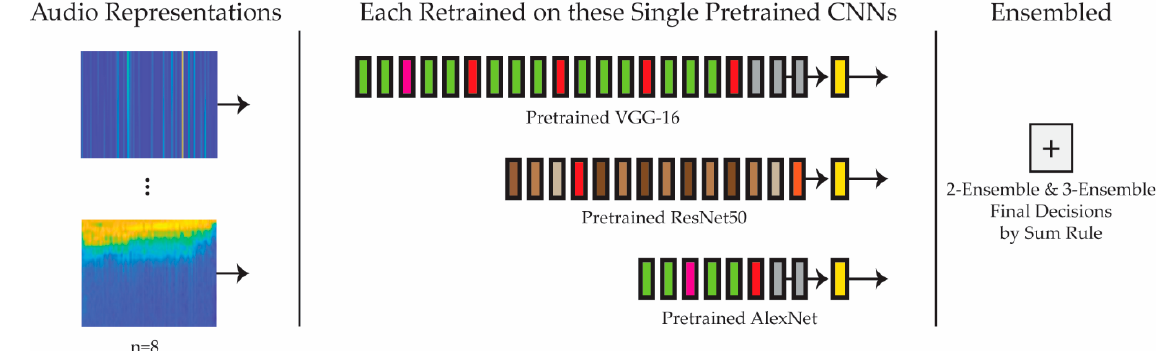
Figure 1. Overview of the proposed system. Each audio representation is trained on each of the three pretrained CNNs, some of which are ensembled (in groups of two or three) by Sum Rule.